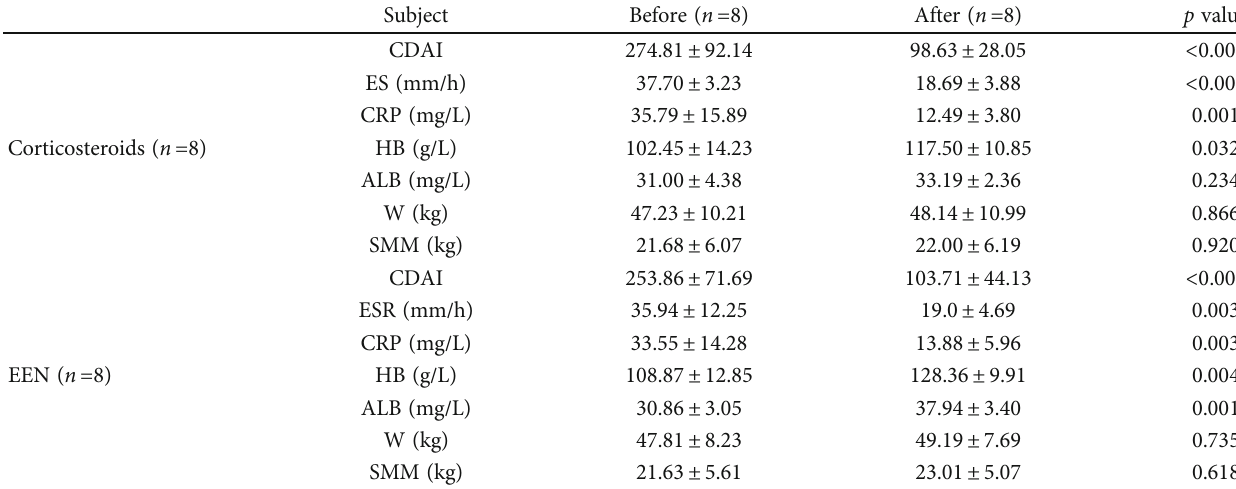
Table 2: Clinical outcome of corticosteroids and EEN therapy.